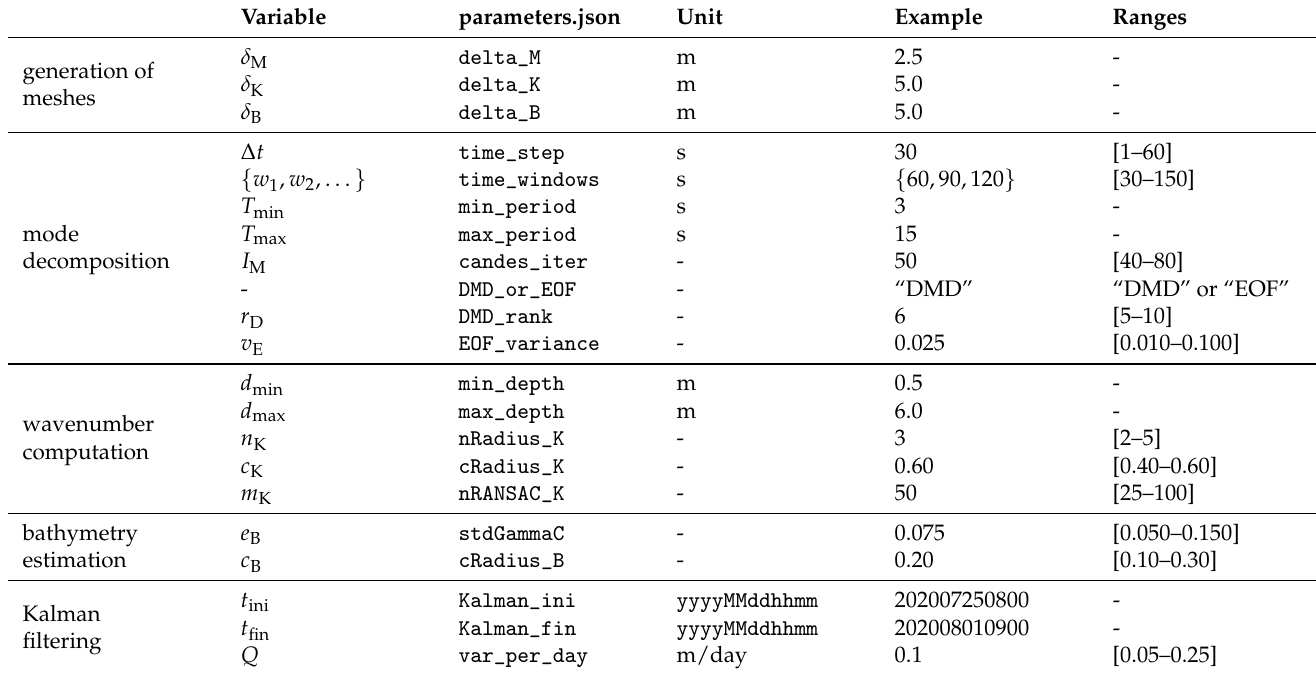
Table 1. List of variables in parameters.json , including the present nomenclature, the names in parameters.json , the reference values considered in the examples and a suggested range of use (whenever it is not site